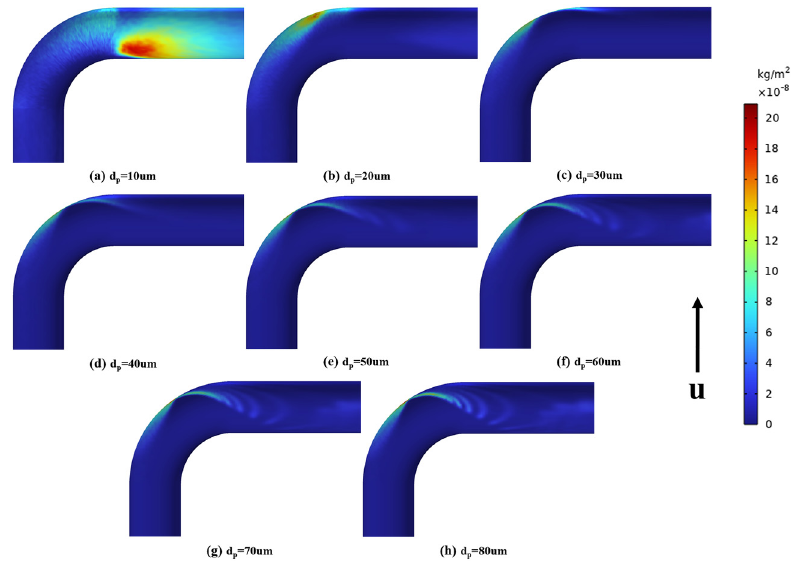
Figure 22. Erosion nephogram with distribution on pipeline side with different particles.